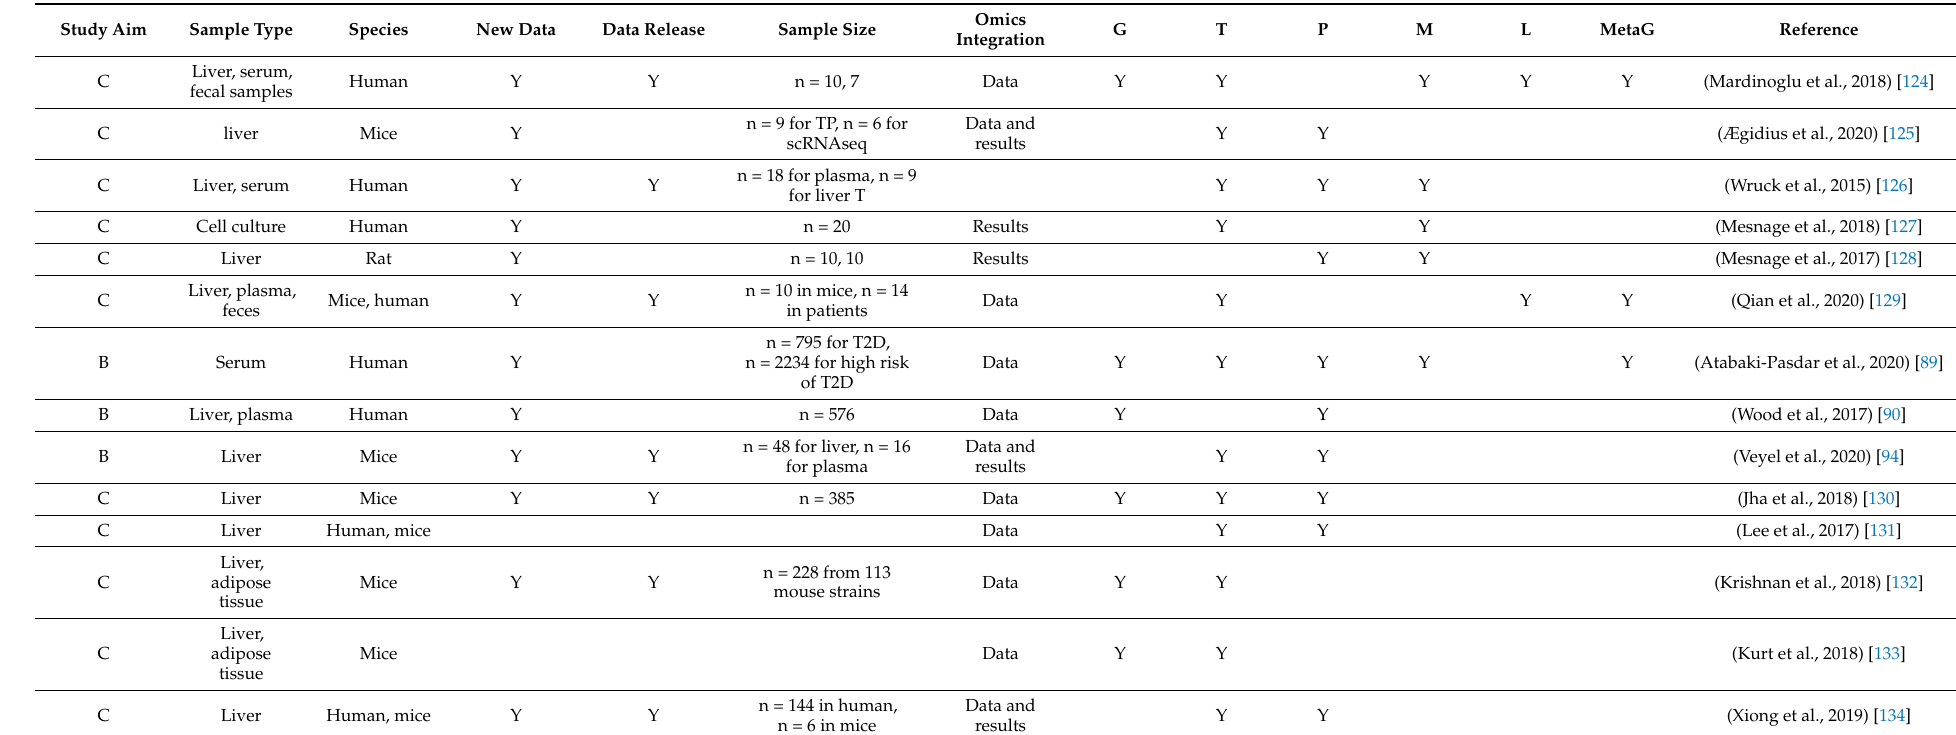
Table 4. Overview of multi-omics studies in